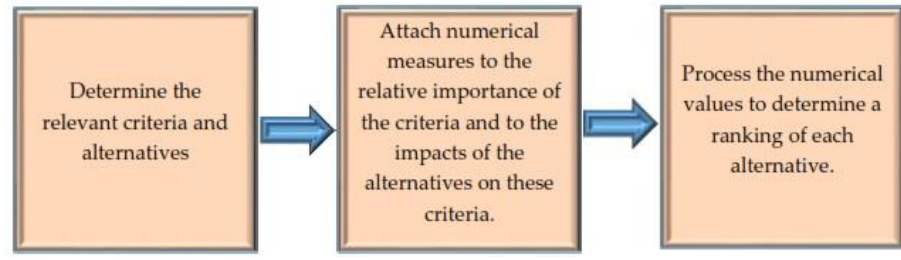
Figure 1. General flow of multicriteria decision-making model (MCDM) model [7,8]